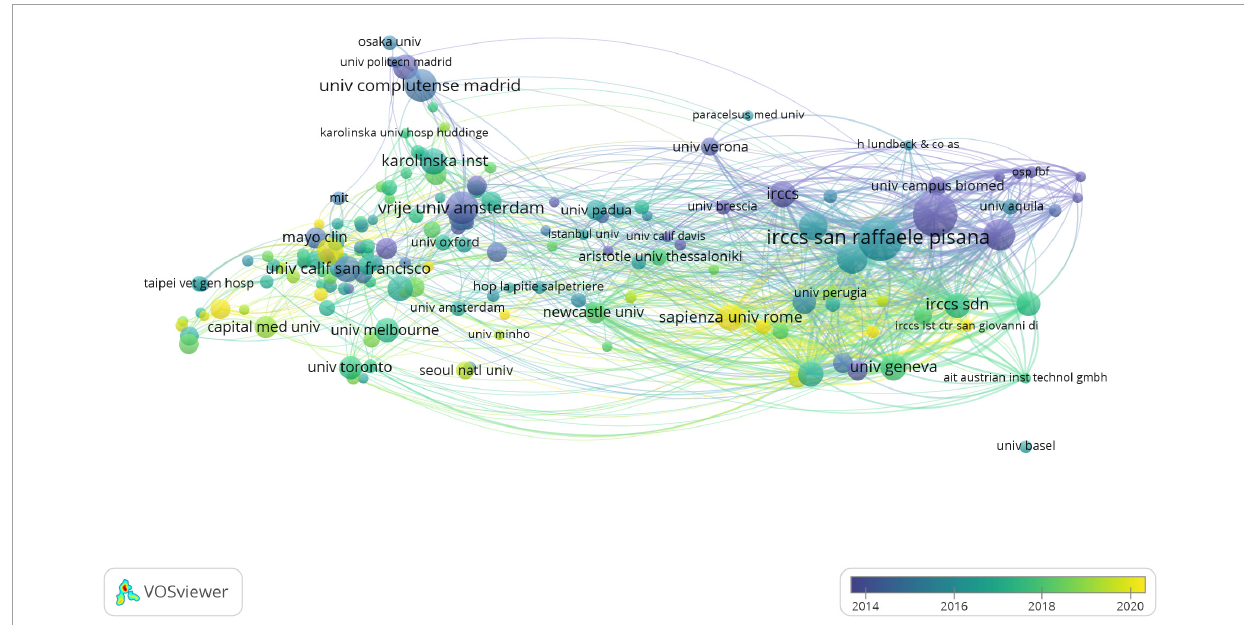
FIGURE4 The institutions’ collaboration network visualization map generated by VOSviewer software. The size of the node denotes the number of publications, the line shows the collaboration. The color’s depth correlates to the time axis. The longer the organization has been working in this field, the deeper the color; and the shorter the organization has been involved in this field, the lighter the color.